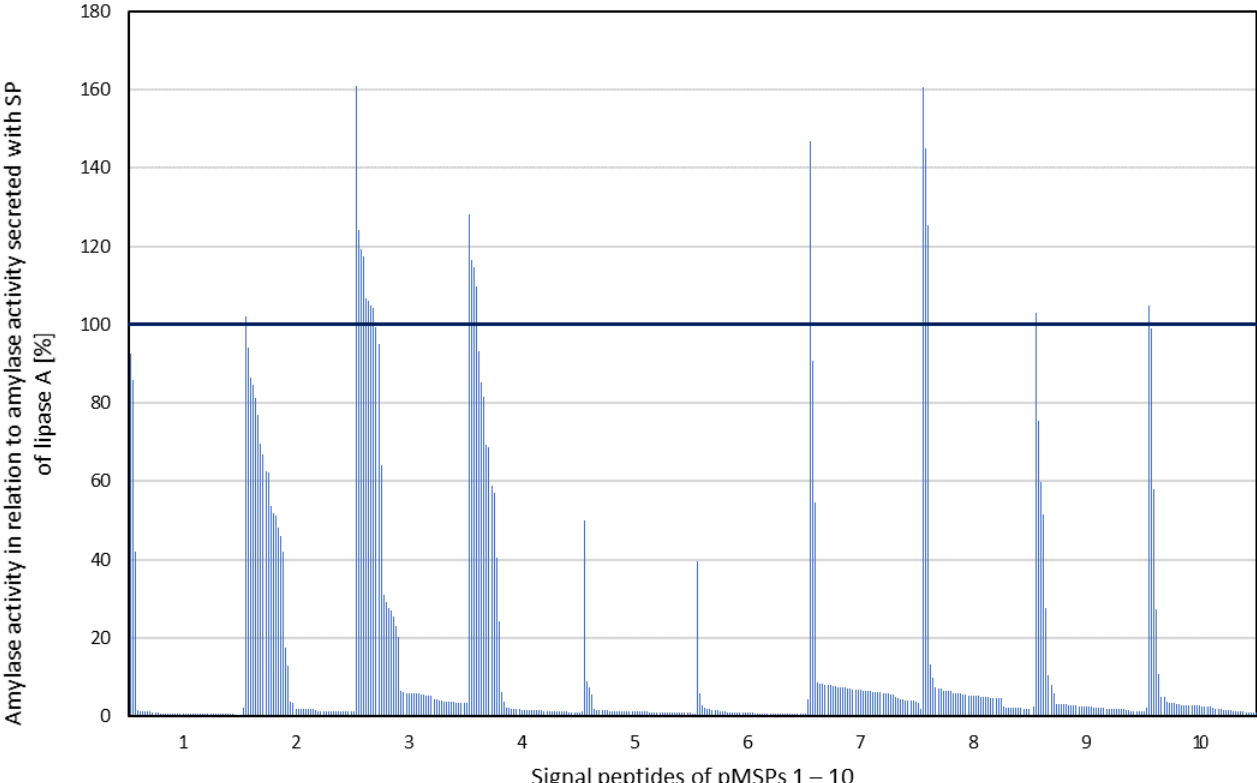
Figure 4. Activity of α -amylase AmyE in the cell-free supernatant recombinantly secreted by P. megaterium MS941 with SPs from pMSP1 to 10. The measured enzyme activity was related to the scattered light at 620 nm of the culture. Enzyme activity is given as a percentage and refers to the positive control (100%), in which the α -amylase is recombinantly secreted by the SP from lipase A of P. megaterium ATCC 9885. Cultivation was performed in a microbioreactor system with 1 mL of LB medium supplemented with tetracycline (10 µ g mL − 1 ) and 0.5% ( w / v ) xylose at 37 ◦ C and 1400 rpm. After 24 h, α -amylase activity in the cell-free culture supernatant was determined photometrically (OD 620 ).